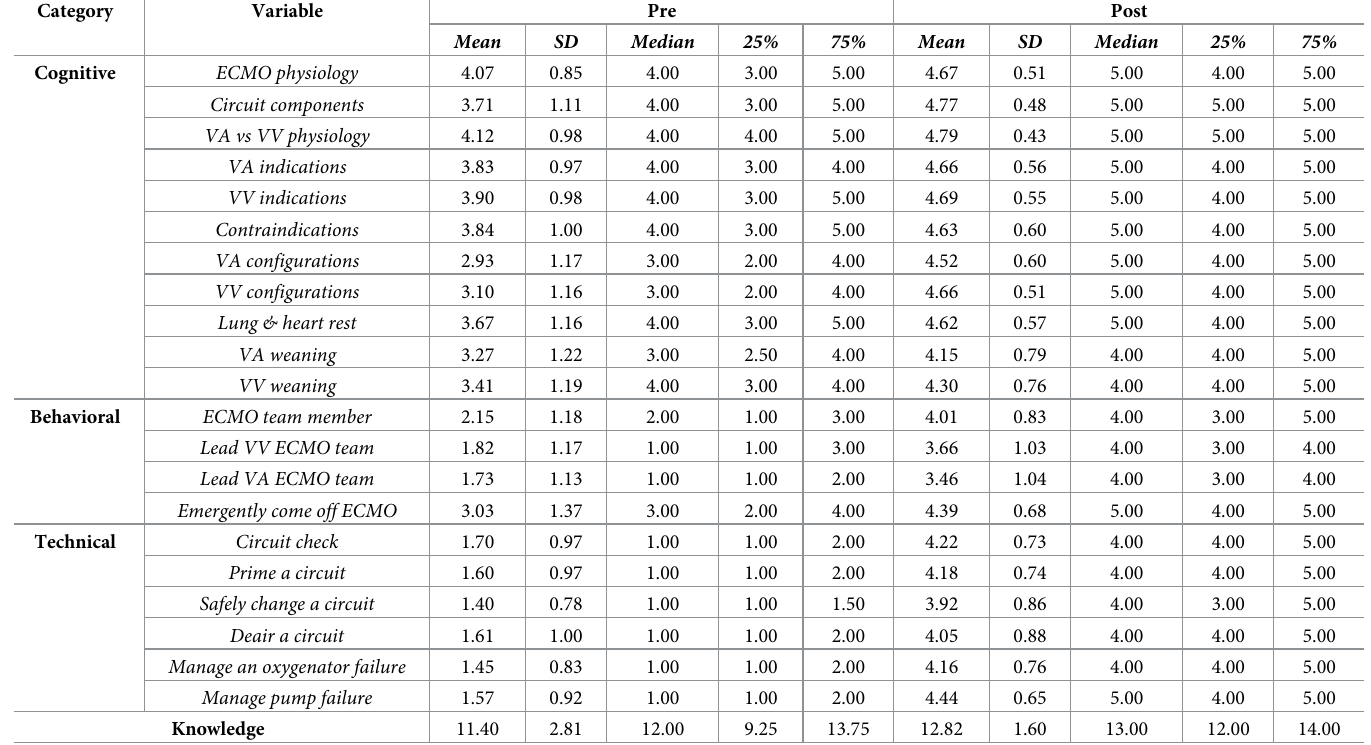
Table 4. Cognitive, behavioral, technical and knowledge pre and post-course assessment. Category